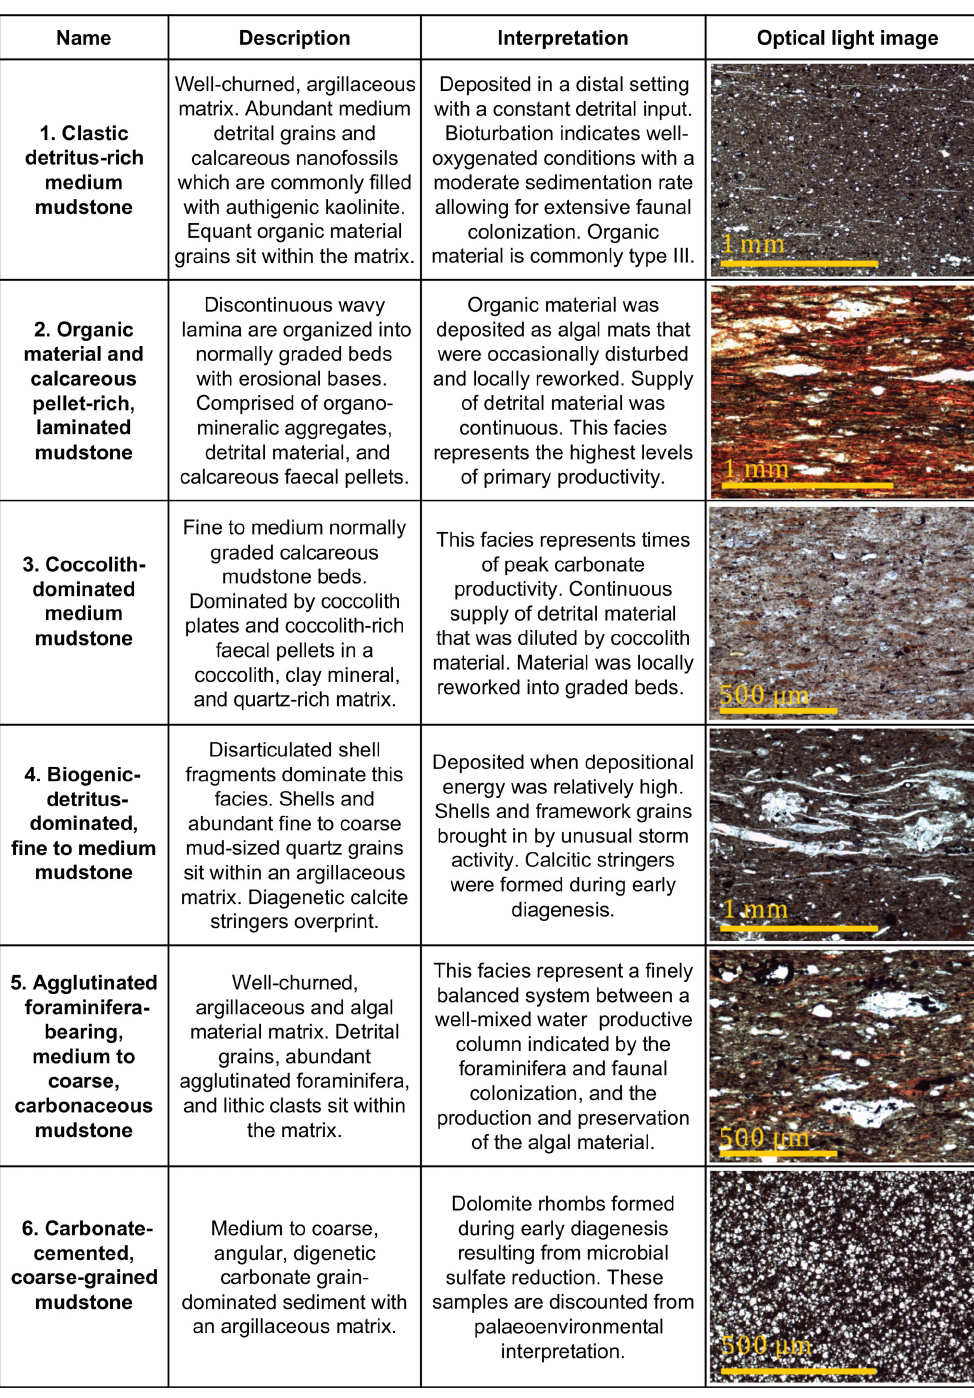
Figure 3. Summary table describing the six lithofacies identified in the petrographic study. Key descriptions and interpretations are noted for each facies along with a representative micrograph. All images are under plain polarized light. For further description, see the